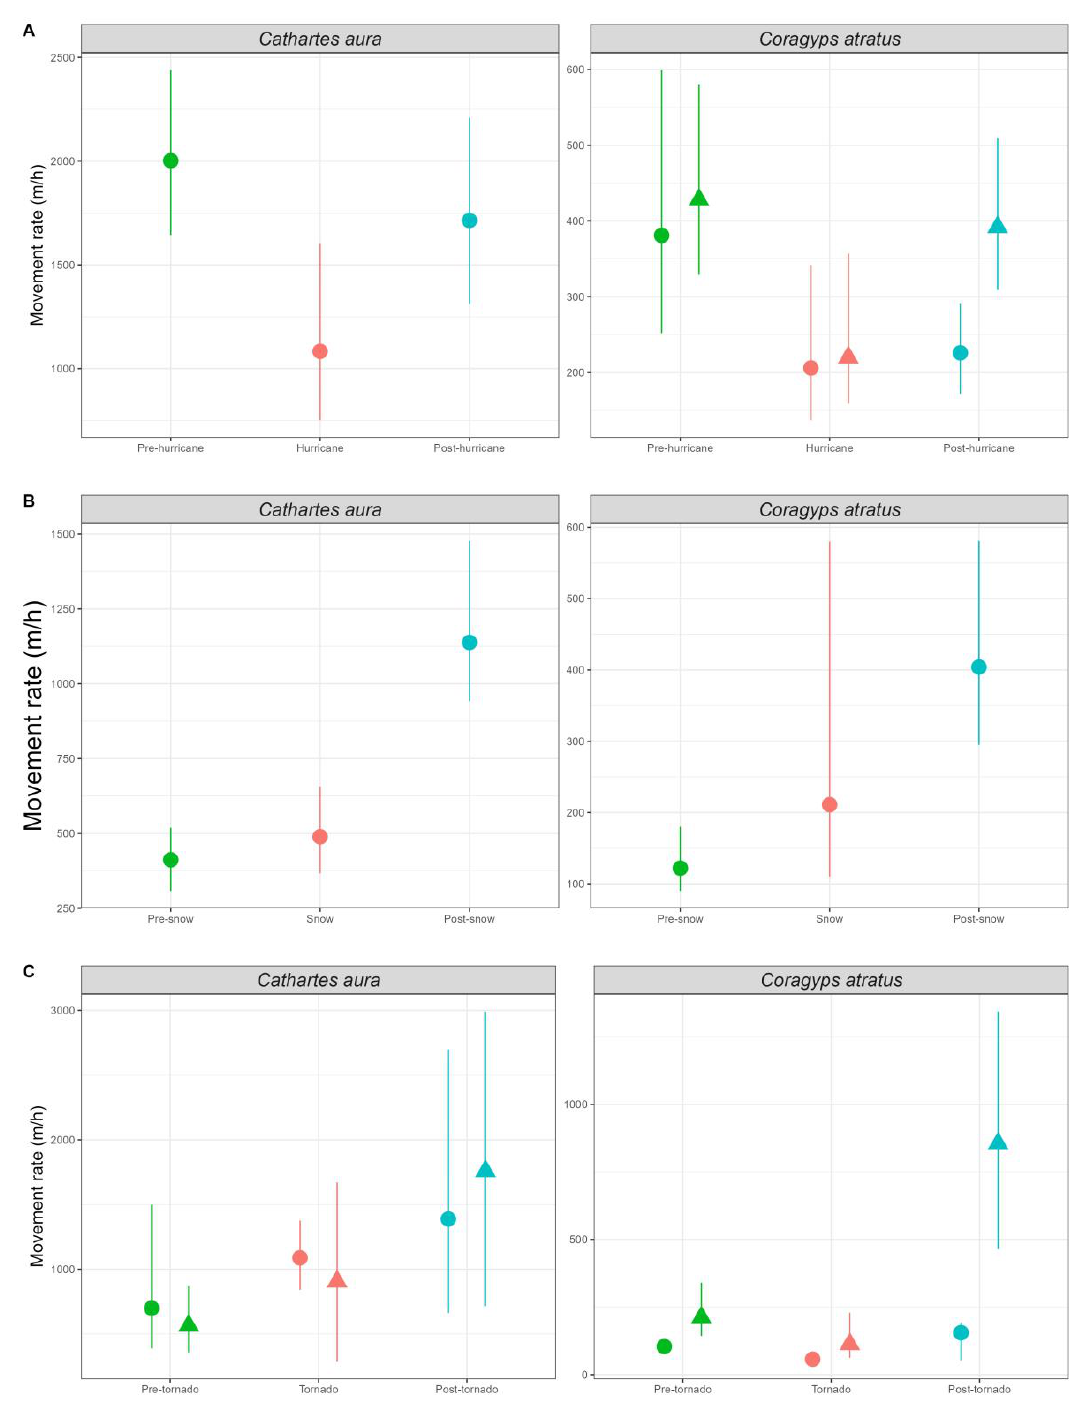
Figure 3. Movement rates (meters/hours) of black and turkey vultures ( Coragyps atratus and Cathartes aura , respectively) before, during, and after extreme weather events in Mississippi, MS, USA. ( Panel A ) = Hurricane Zeta. ( Panel B ) = Winter storm Viola. ( Panel C ) = Tornadoes Duffee and Toomsuba. Green = before the event. Pink = during the event. Blue = after the event. Circles = vultures directly affected. Triangles = vultures not directly affected. Panels without triangles = all birds were directly affected by storms evaluated.